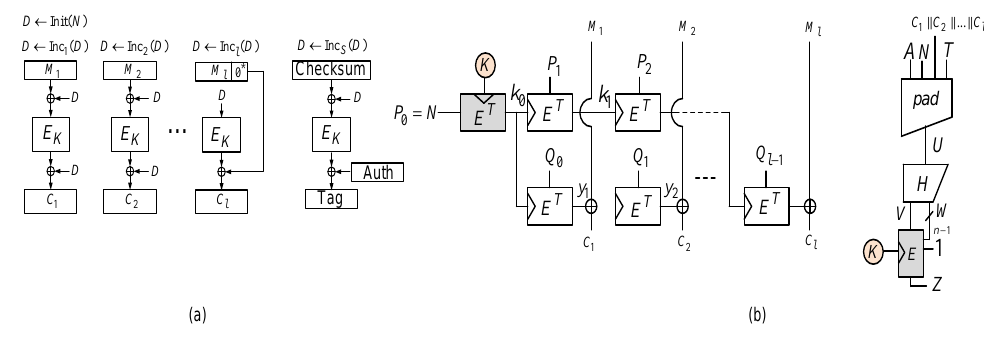
Figure 1: Impact of faults on long-term secret: (a) OCB; (b)